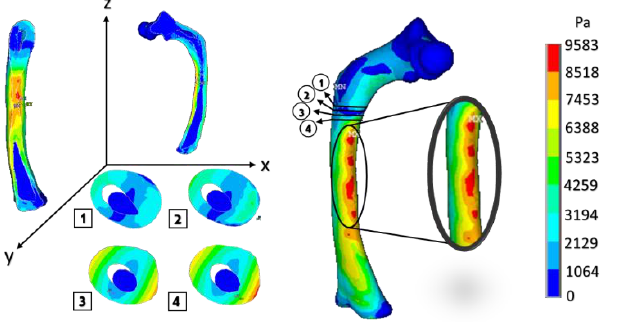
Figure 15. Orthotropic analysis. Von Mises stress showing maximum stress of 9.583 Pa.